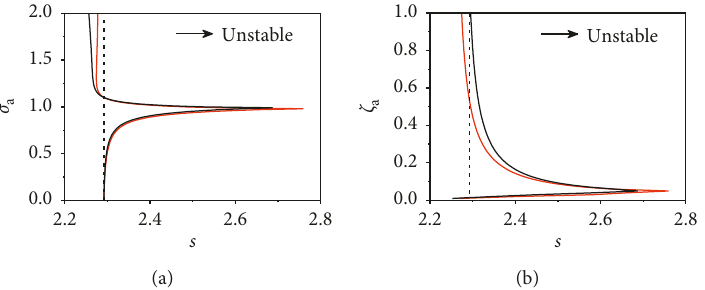
Figure 11: The comparison results of the relationship between instability threshold speed and (a) the frequency ratio σ ratio ζ a .